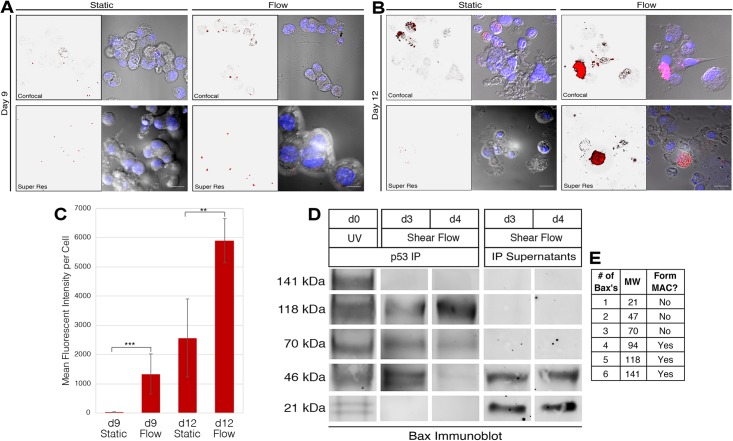
p53 binds and oligomerizes Bax in Mks following shear-flow exposure.(A,B), Confocal and Super Resolution microscopy (as labeled) of the Proximity Ligation Assay (PLA) between acetyl-p53 (K373) and Bax. Red: Interaction-dependent fluorophore; Blue: DAPI. Scale bar: 5μm. C, MFI of interaction-dependent fluorophores from the confocal microscopy images shown in A and B. The cell number for quantification vary from 10 to 20. Statistical analysis is performed by Student’s t-test, **p < 0.01, ***p < 0.001. D, Co-immunoprecipitation of p53 immunoprecipitation and Bax immunoblot demonstrating the interaction between the two proteins, as well as the oligomeric status of Bax in the complexes. E, Hypothesized molecular weights (MW) for each oligomer of Bax, as determined by Antonsson, et al. [35], and whether the respective Bax oligomer can form a mitochondrial apoptosis-induced channel (MAC), as determined by Saito, et al. [36].